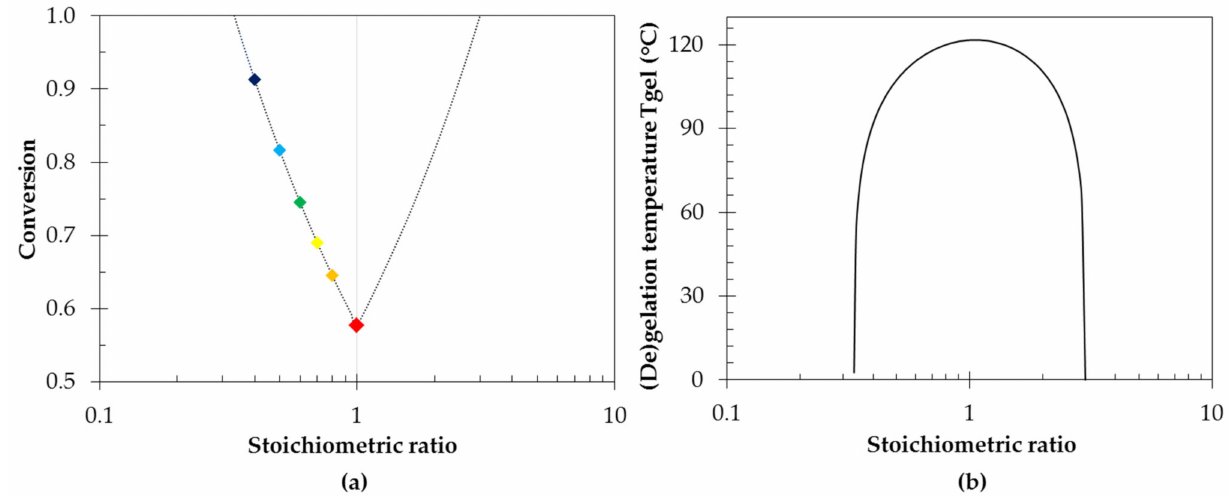
Figure 7. The simulated critical gel conversions ( a ) and the simulated equilibrium gel transition temperatures ( b ) for [4 + 2] networks as a function of stoichiometric